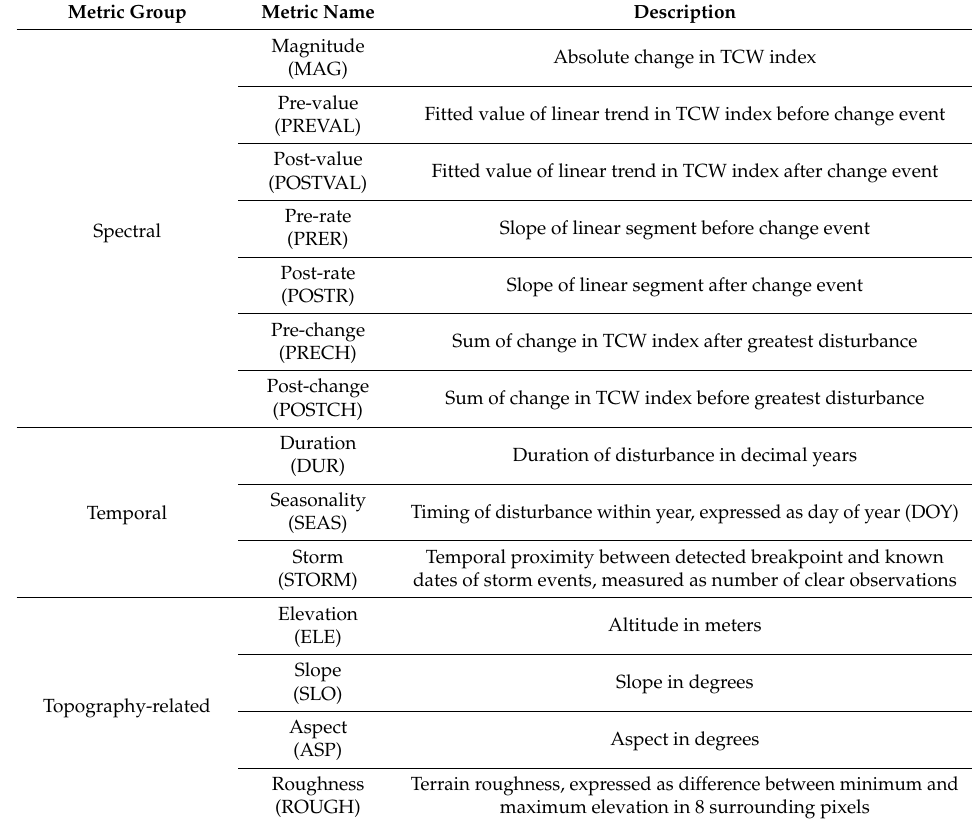
Table 3. Overview of spectral metrics based on Tasseled Cap Wetness (TCW), temporal and topography-related metrics used for disturbance agent